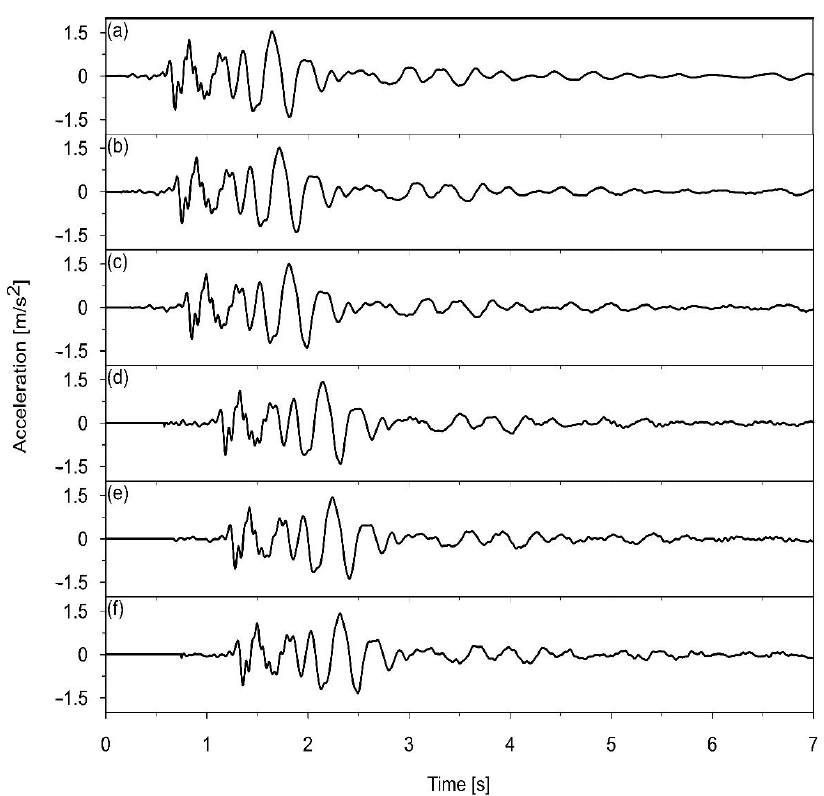
Figure 14. The horizontal (WE) acceleration-time histories of subsequent bridge supports generated on the basis of the SMIKE model: ( a – f ) subsequent supports.